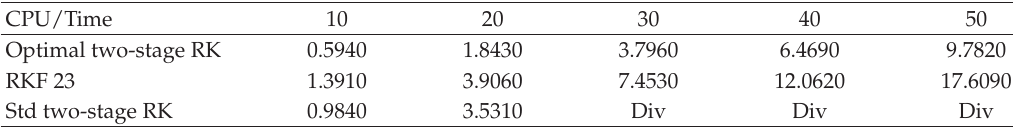
Table 4: Comparison of CPU time among the optimal two-stage RK, RKF 23, and standard two-stage RK with Δ t (cid:6) 0 . 001.